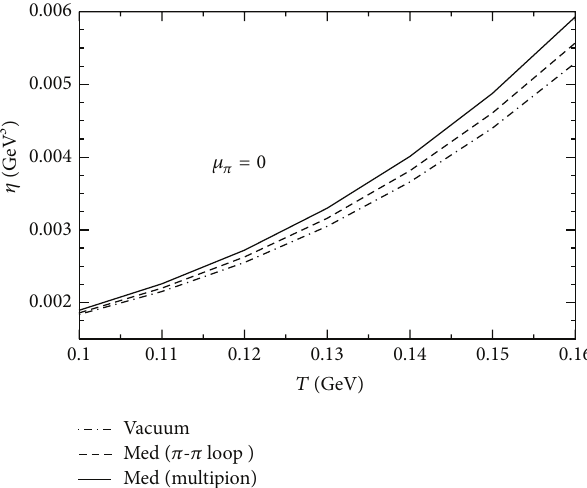
Figure 5: The shear viscosity as a function of temperature in the Chapman-Enskog approximation. The dash-dotted line indicates use of the vacuum cross-section, and the dashed and solid lines correspond to in-medium cross-section for the 𝜋𝜋 and multipion cases